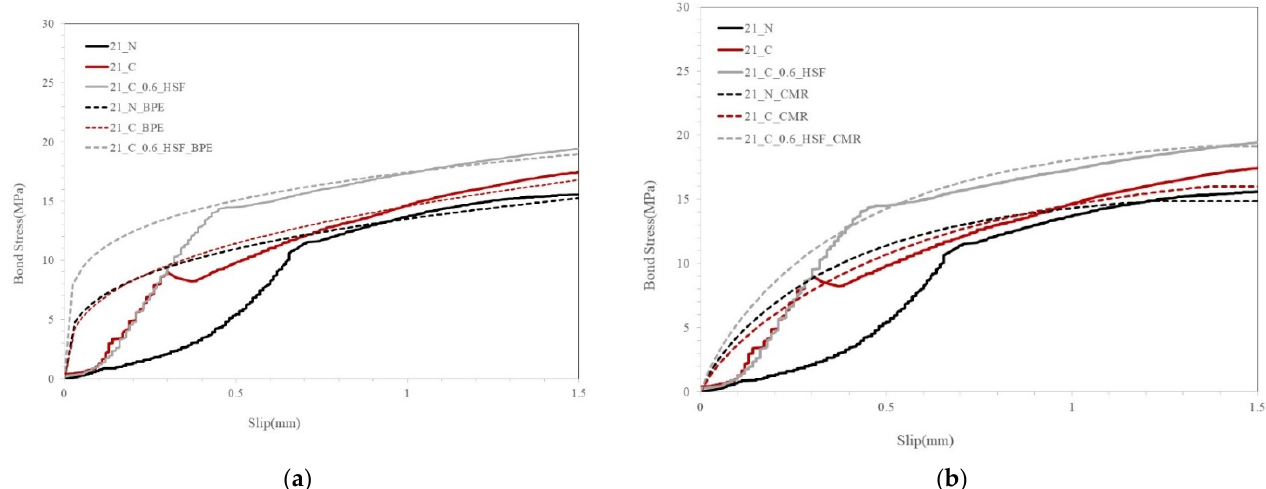
Figure 14. Comparison of BPE (a) and CMR (b) models for steel rebar coated and reinforced with UHPC.